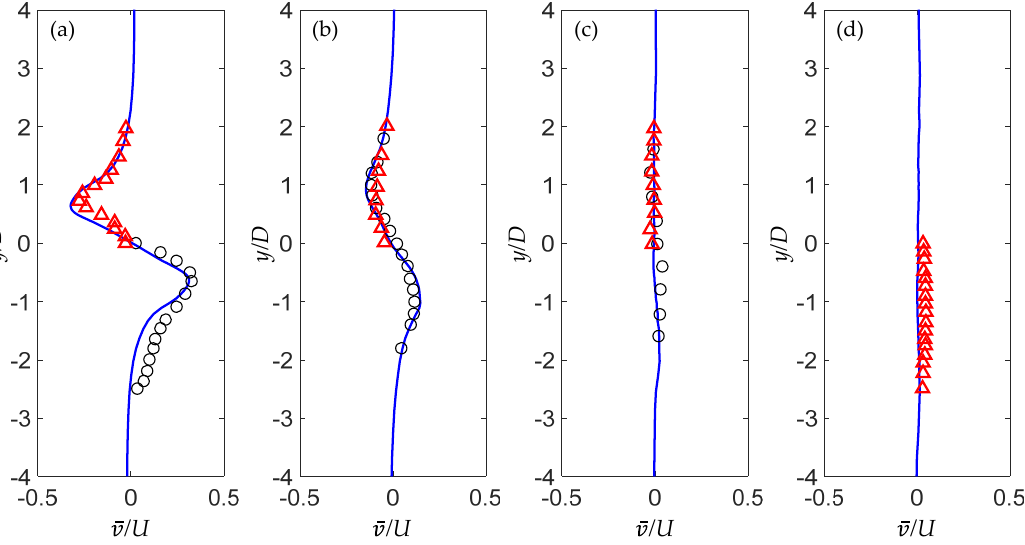
Figure 4. Comparison of the time-averaged transverse velocity profiles at different downstream locations for a square cylinder in crossflow ( α = 0 ◦ ). ( a ) − : present study, x = 1 D ; (cid:52) : Lyn et al. [15], x = 1 D